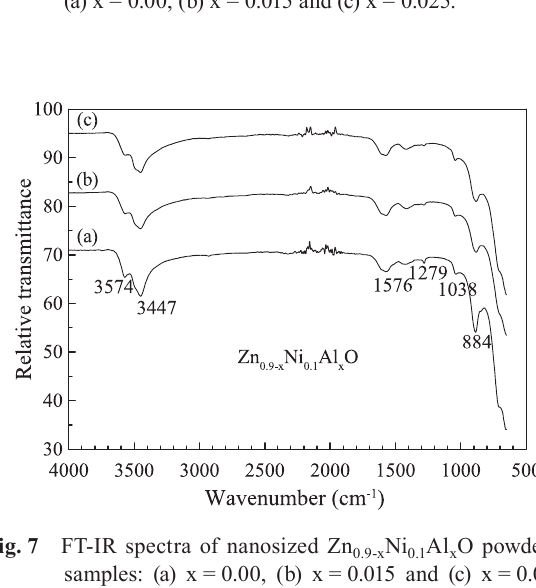
Fig. 7 FT-IR spectra of nanosized Zn 0.9-x Ni 0.1 Al x O powdered samples: (a) x = 0.00, (b) x = 0.015 and (c) x = 0.025. The spectra are recorded at room temperature and ver- tically offset for